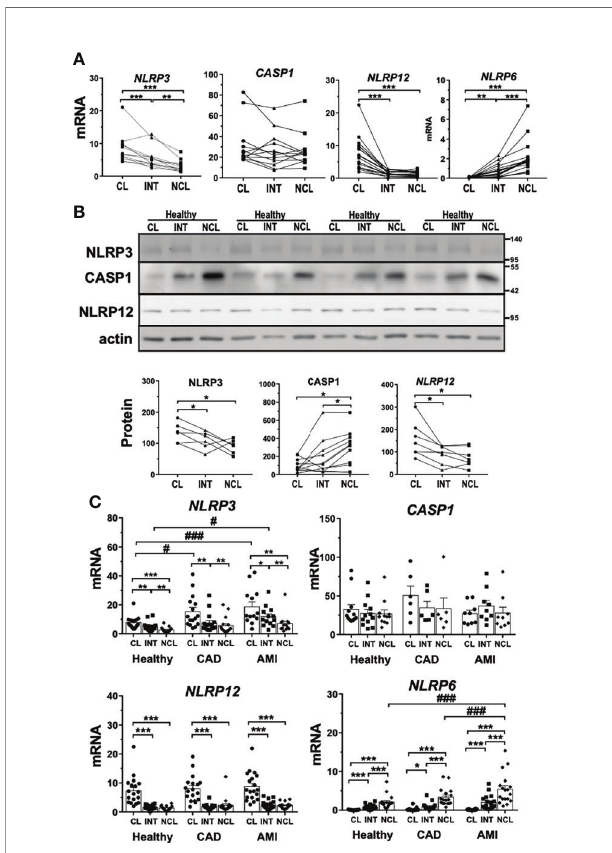
FIGURE 2 | Basal expression of in fl ammasome-associated genes differs between human monocyte subpopulations. Basal expression of various in fl ammasome-associated genes in untreated monocyte subpopulations from healthy donors. (A) mRNA expression measured by qPCR (n = 8-15) and (B) protein levels by immunoblotting (n = 4-11) revealed striking differences for NLRP3 and 12, as well as CASP1 between subpopulations. (C) Comparing healthy to CAD or AMI monocytes revealed increased gene expression of NLRP3 in classical monocytes and of NLRP6 in non-classical monocytes of AMI patients; * compared to classical; # compared to healthy; * or # p < 0.05; ** or ## p ≤ 0.01; *** or ###p ≤